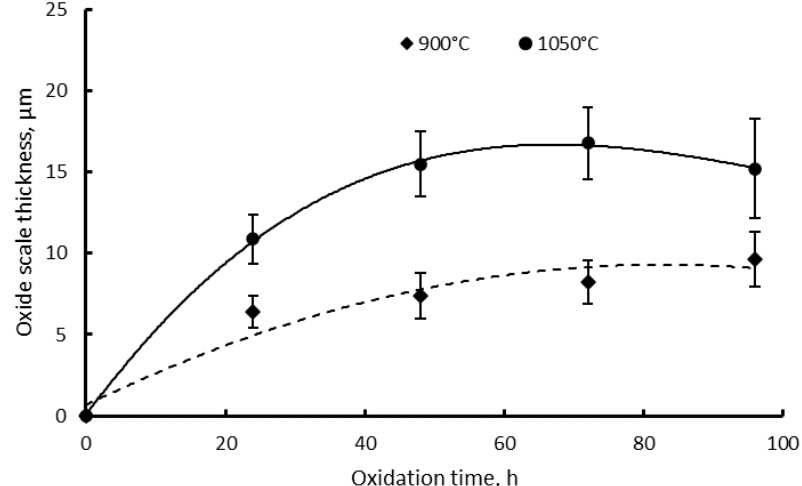
Figure 10. Oxide scale thickness as a function of time and standard deviations after isothermal oxidation of IN 625 at 900 °C and 1050 °C.